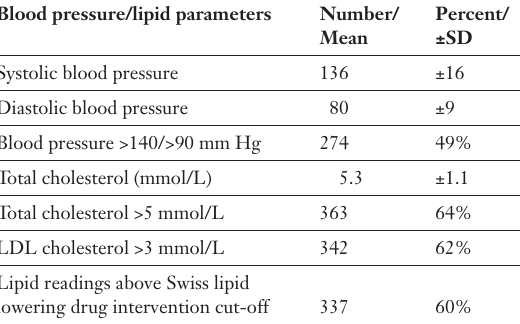
Blood pressure and lipid levels among Swiss outpatients with coronary heart disease.